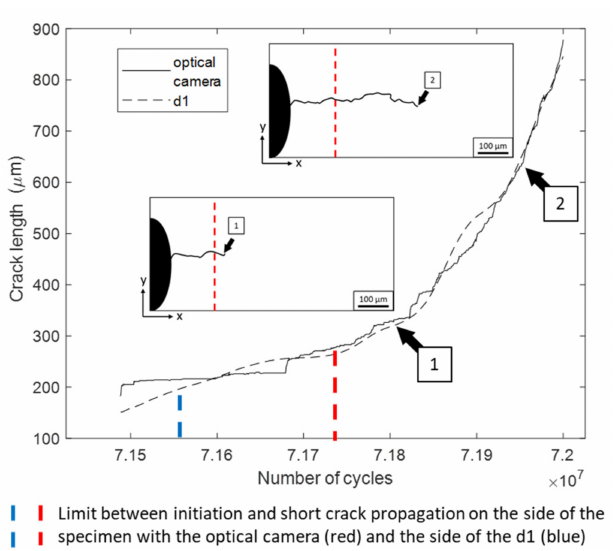
Figure 9. Evolution of the crack length in terms of the number of cycles. Two instant of crack growth that marked point 1 and 2 illustrate evolution of crack length and